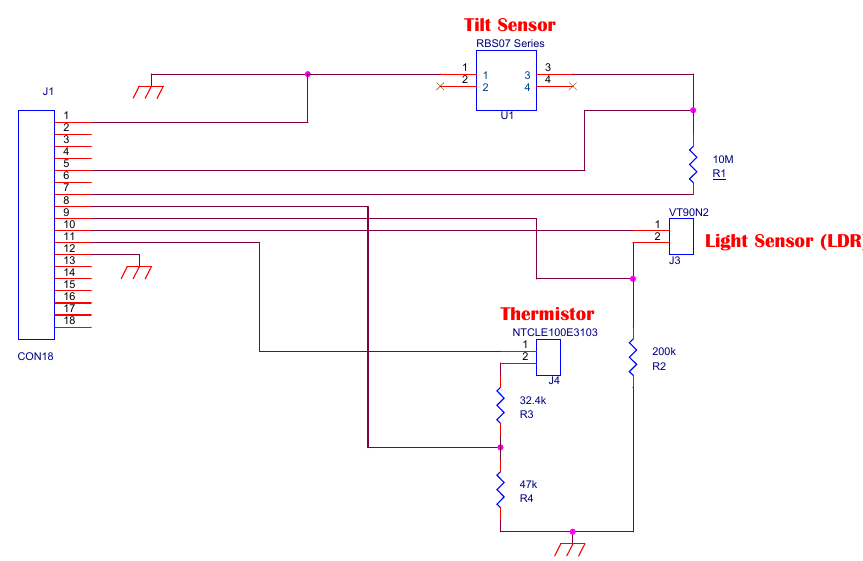
Figure 5. Schematic representation of the interconnection between the wireless node and the